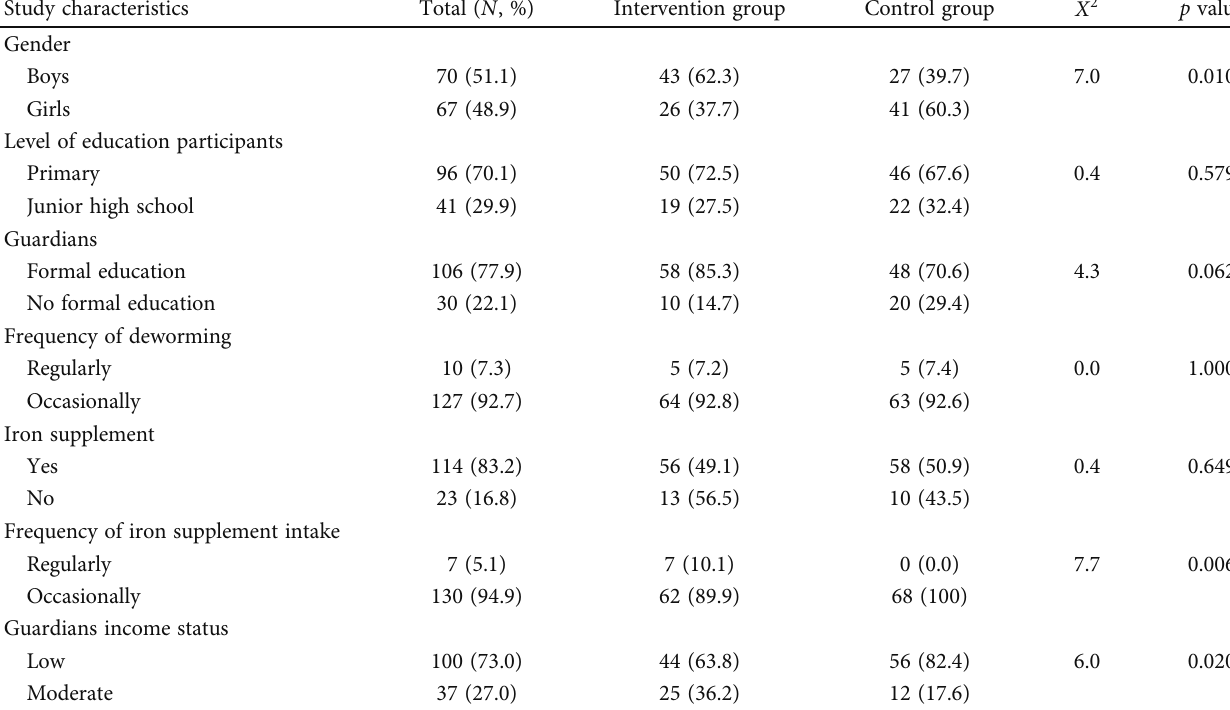
Table 2: Characteristics of the participants and guardians by study